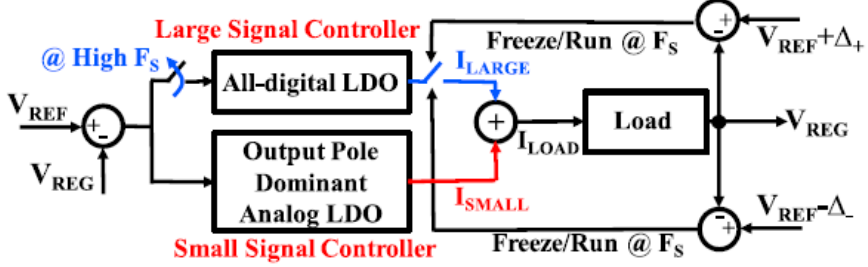
Figure 35. Switched-Mode-Control-based HD-LDO